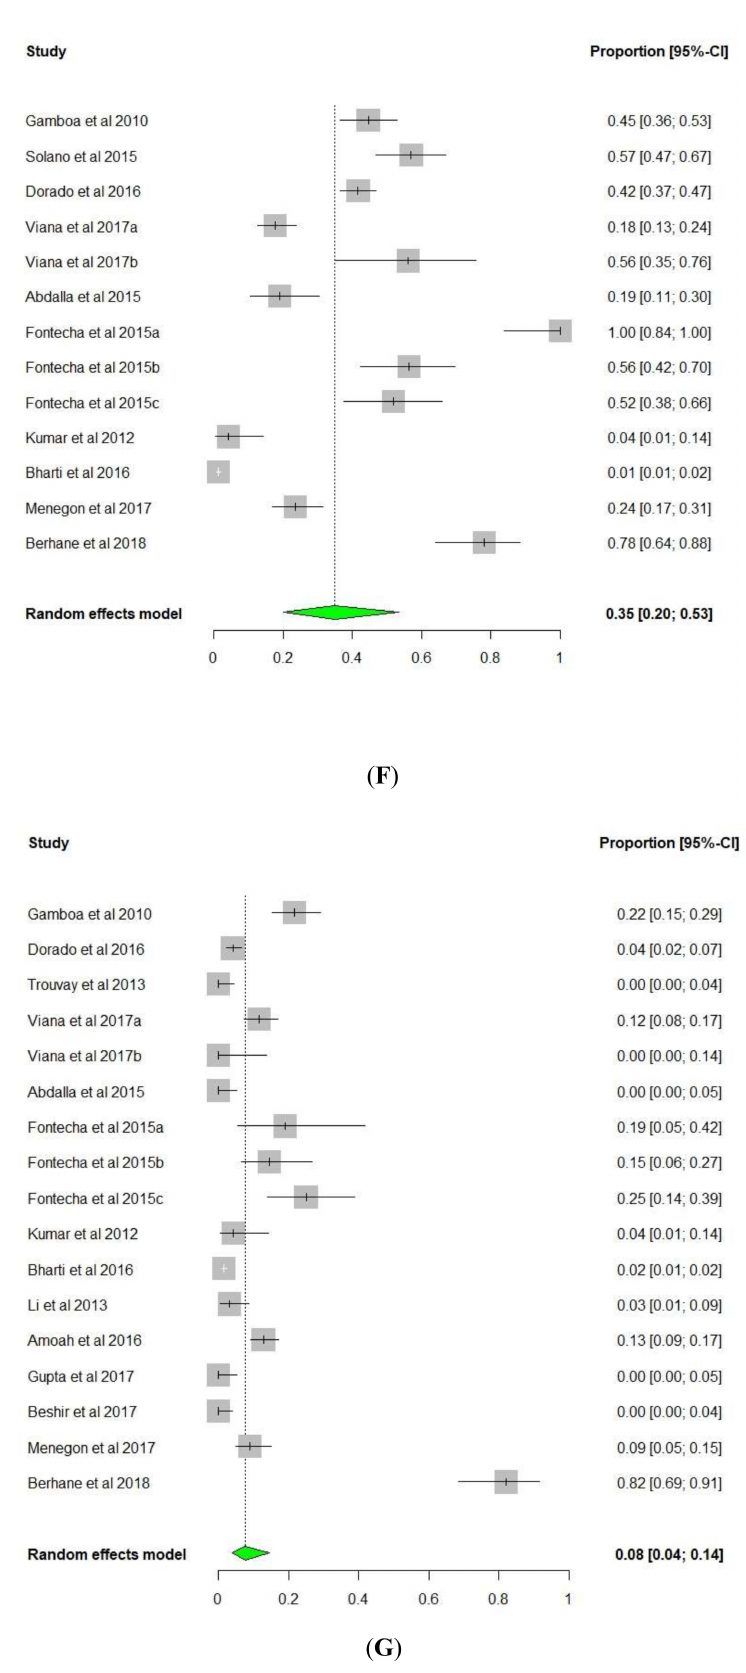
Figure 4. Forest plot showing the prevalence of ( A ): ( pfhrp2 exon1-2) ( B ): (Upstream MALP1.230 ) ( C ): (Downstream MALP1.228 ) ( D ): ( pfhrp3 exon1-2), ( E ): (Upstream MAL13P1.475 ) ( F ): (Downstream MAL13P1.485 ), and ( G ): (Double negative for pfhrp2 and pfhrp3